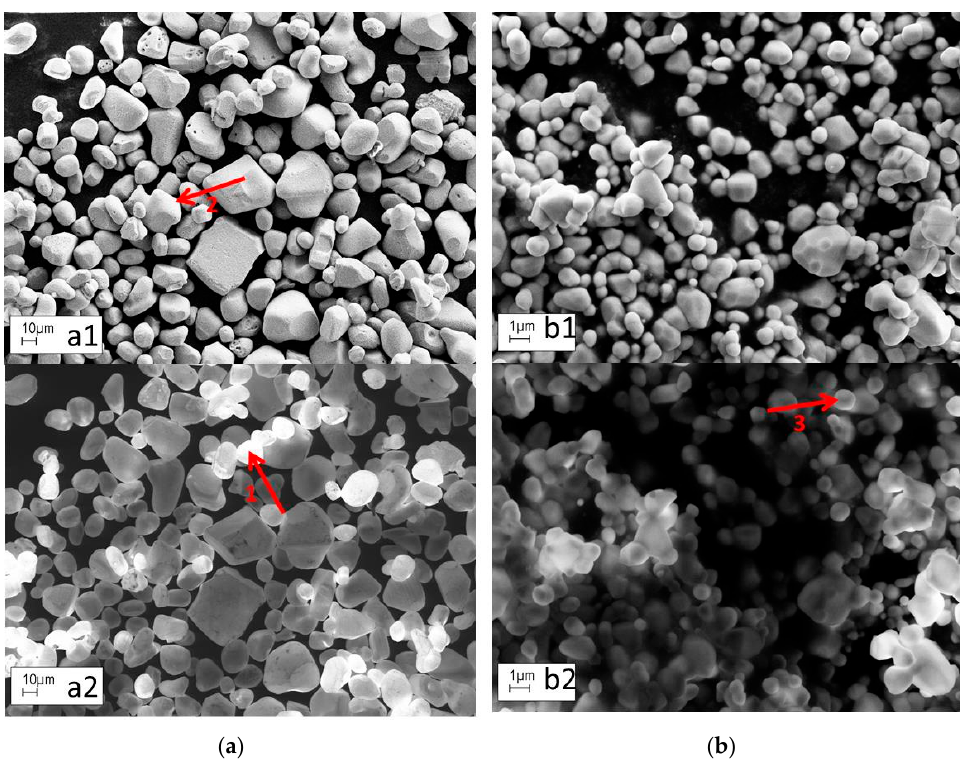
Figure 5. SE ‐ and CL ‐ images of ZnS:Cu,Cl and ZnO:Zn ( b ) at an e ‐ beam voltage of 10 kV: ( a1 ) SE ‐ image for ZnS; ( a2 ) CL image for ZnS; ( b1 ) SE ‐ image for ZnO; and ( b2 ) CL ‐ image for ZnO. Substrate is carbon, which has low BS ‐ and SE ‐ coefficients. Same areas are shown in ( a1 ) and ( a2 ); and in ( b1 ) and ( b2 ). Please note that the ZnS particles are more than 10 times larger than the ZnO particles.